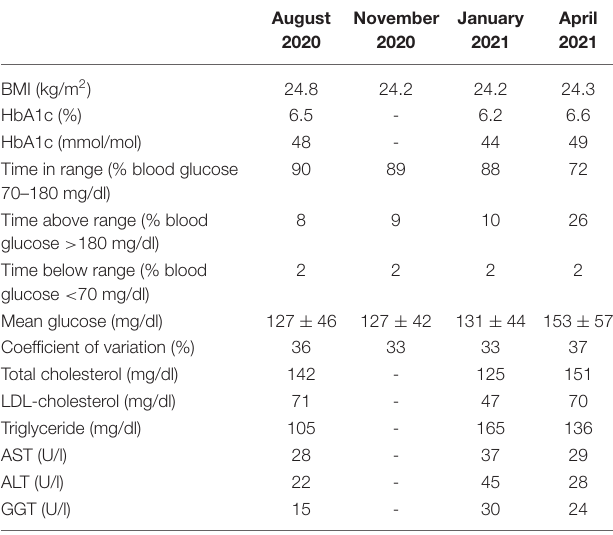
TABLE 1 | Anthropometric, blood glucose control, and biochemical parameters.